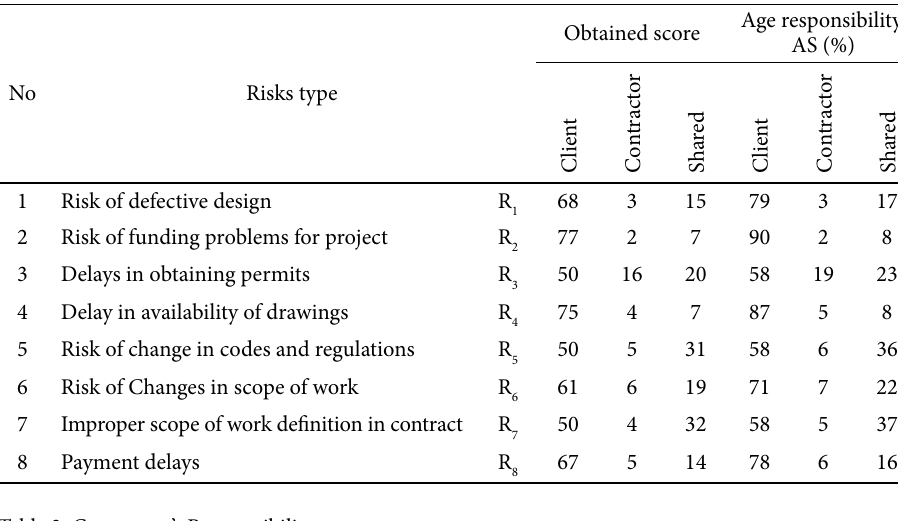
Table 1. Client’s Responsibility